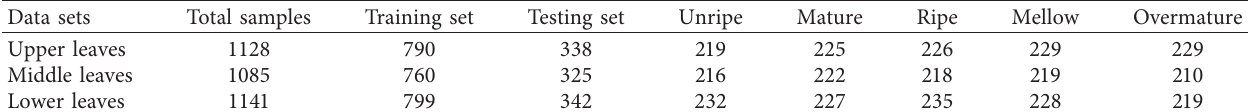
Table 2: The detail of tobacco leaves data sets.